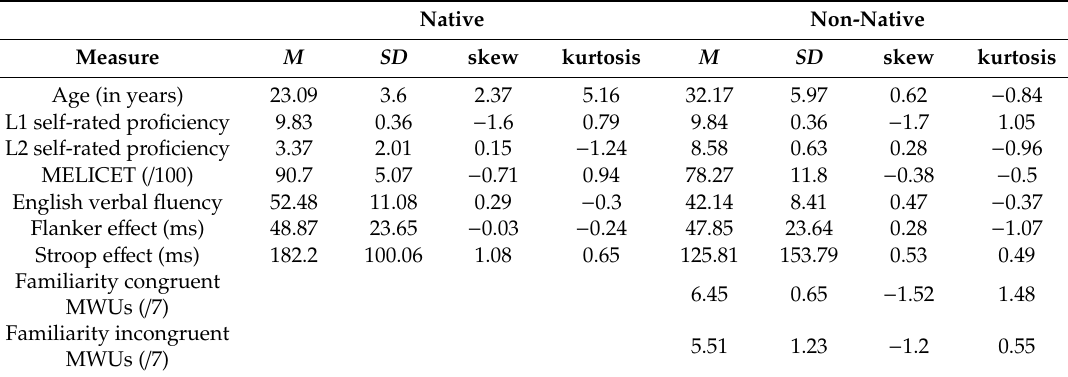
Table A3. Additional data for cognitive and proficiency measures.